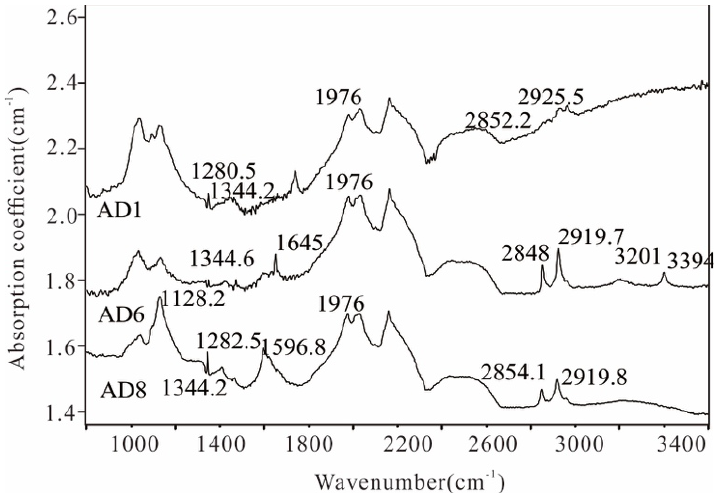
Figure 3. Infrared absorption spectrum collected from diamond AD1, AD6 and AD9 exhibiting both A and C centre.